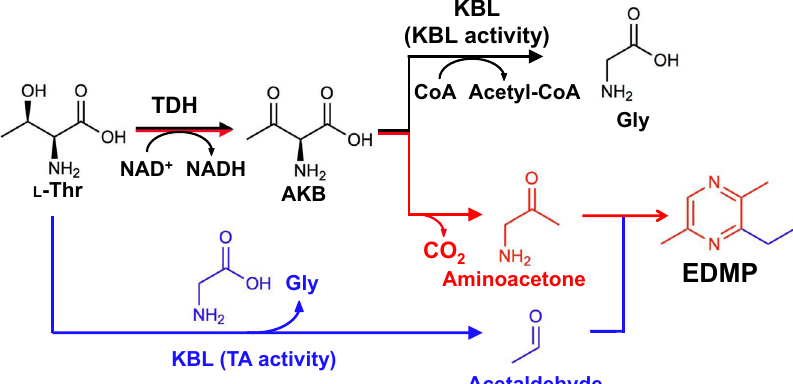
Fig. 8 Proposed synthesis pathway of EDMP from L-Thr using TDH and KBL enzymes. TDH converts L-Thr to AKB and AKB is metabolized to Gly by the acetyltransferase activity of KBL in usual conditions. However, in poor nutrition and at low CoA concentrations, unstable AKB is gradually decarboxylated to aminoacetone (red) and the lyase activity of KBL decomposes L-Thr to acetaldehyde and Gly (blue). EDMP is synthesized chemoenzymatically from L- Thr via the condensation reaction of two molecules of aminoacetone and one molecule of